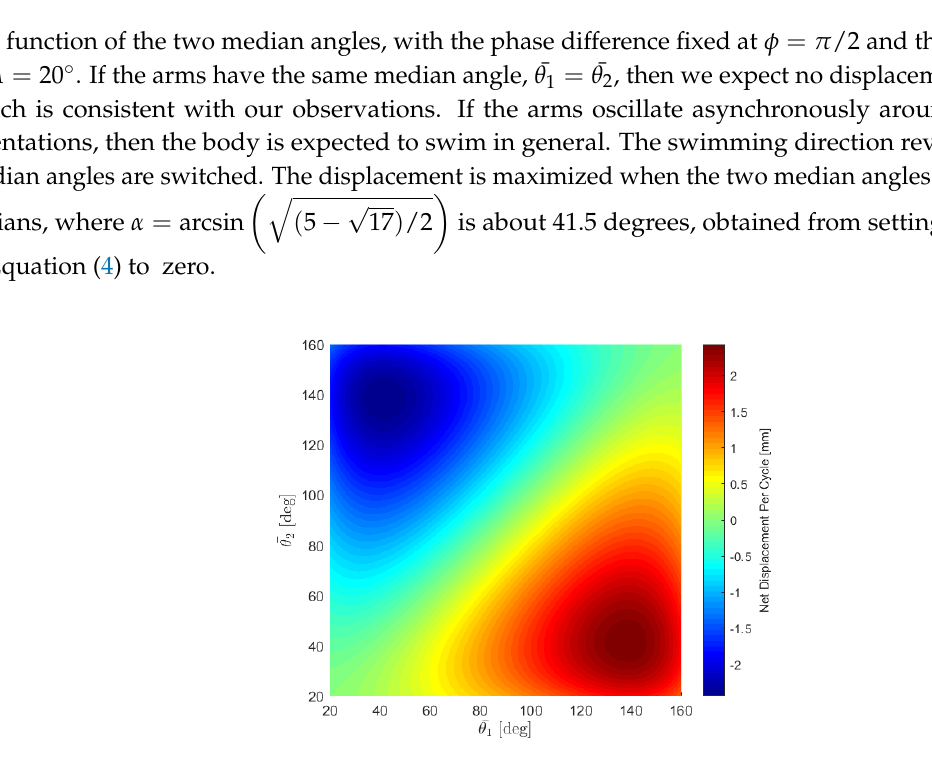
Figure 9. Net displacement per cycle as a function of the median angles with a constant phase difference of π /2 and amplitude of 20 ◦